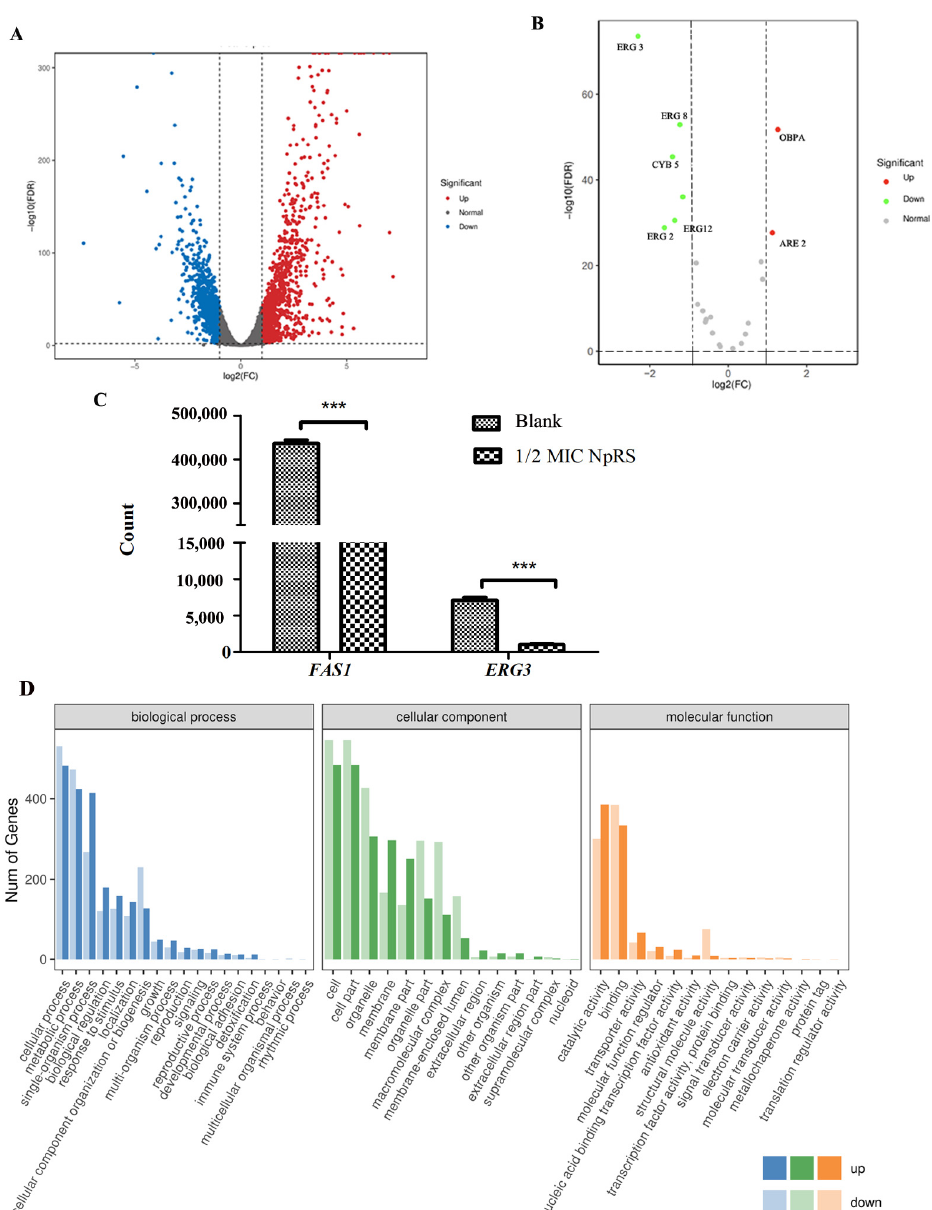
Figure 4. Antifungal mechanism of NpRS explored by transcriptomic analysis. ( A ) Volcano plot of differentially expressed genes of the NpRS treatment group versus the control group. Each dot represents a gene, and the up-regulated and down-regulated genes with the largest fold change are marked in the graph. Fold change is represented on the x-axis, while p adjust is represented on the y-axis. Red and blue indicate differentially up-regulated and differentially down-regulated genes, respectively, while gray dots indicate genes that were not significantly different from the control group; ( B ) Volcano plot of differentially expressed ergosterol-related genes of the NpRS treatment group versus the control group; ( C ) Gene counts of FAS1 and ERG3 ; ( D ) GO enrichment analysis. Genes were annotated in three main categories: biological process, cellular component, and molecular function. All data are expressed as the mean values of triplicate ± standard deviation. *** p < 0.001, compared with blank